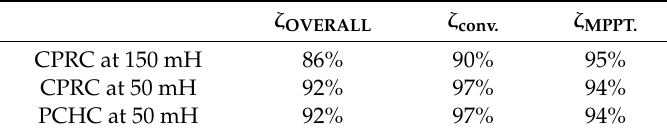
Table 4. Detailed e ffi ciency assessment. Table 4. Detailed efficiency assessment.